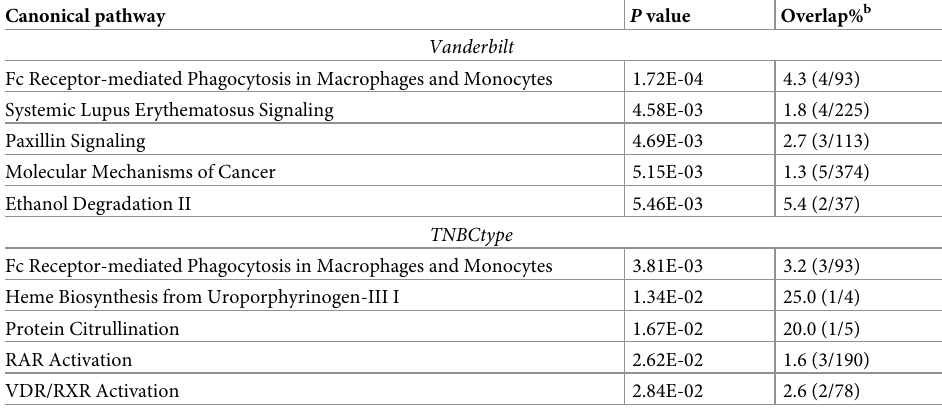
Table 1. Top 5 canonical pathways derived from Ingenuity Pathway Analysis gene ontology algorithms a . Canonical